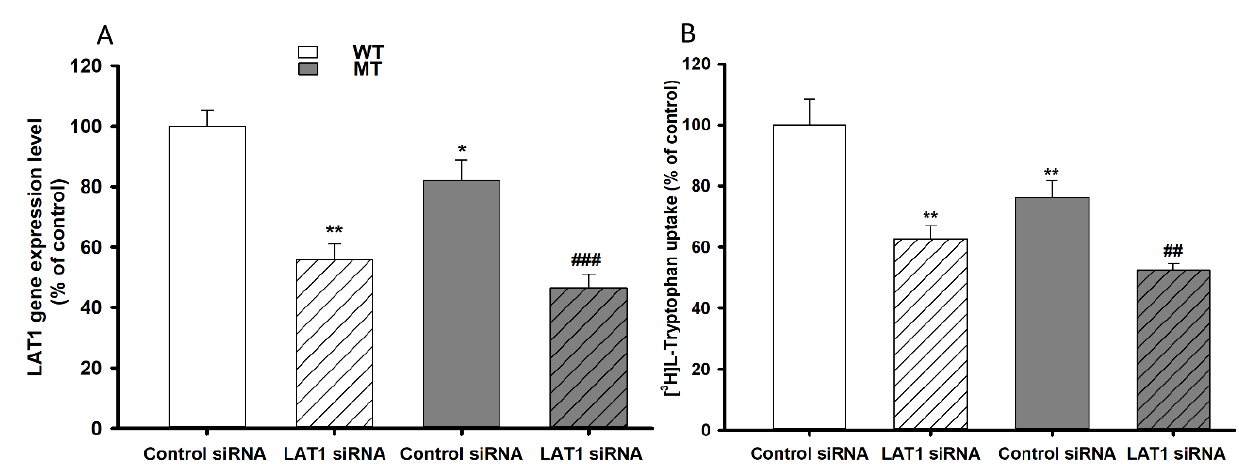
Figure 6. Effects of LAT1 knockdown measured by ( A ) LAT1 mRNA expression and ( B ) [ 3 H] L -tryptophan uptake by transfected NSC-34 cell lines The siRNA transfection was carried out for 24 h, then the mRNA expression and uptake analysis were carried out at 37 °C for 5 min. ** p < 0.01, * p < 0.05 indicate a significant difference from the WT control, ### p < 0.001, ## p < 0.01 indicates a significant difference from the MT control. Each point represents the mean ± SEM ( n = 3–4). WT, wild-type NSC-34 cell lines; MT, mutant-type NSC-34 cell